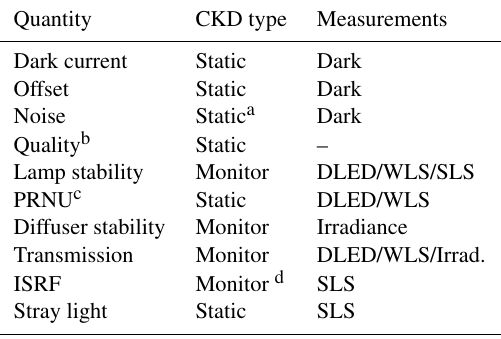
Table 1. Calibration and monitoring data obtained